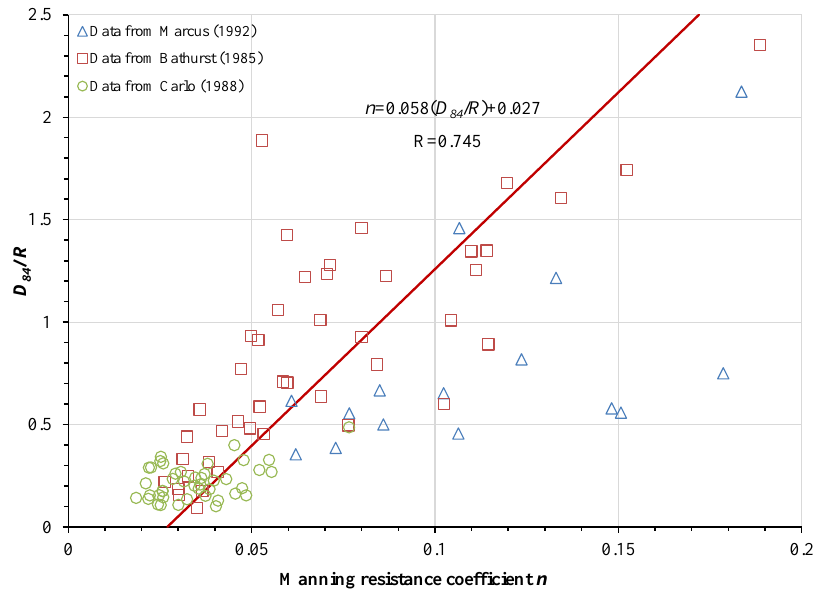
Figure 2. Relationship between the Manning roughness coefficient and D 84 /R . Water 2020 , 12 , x